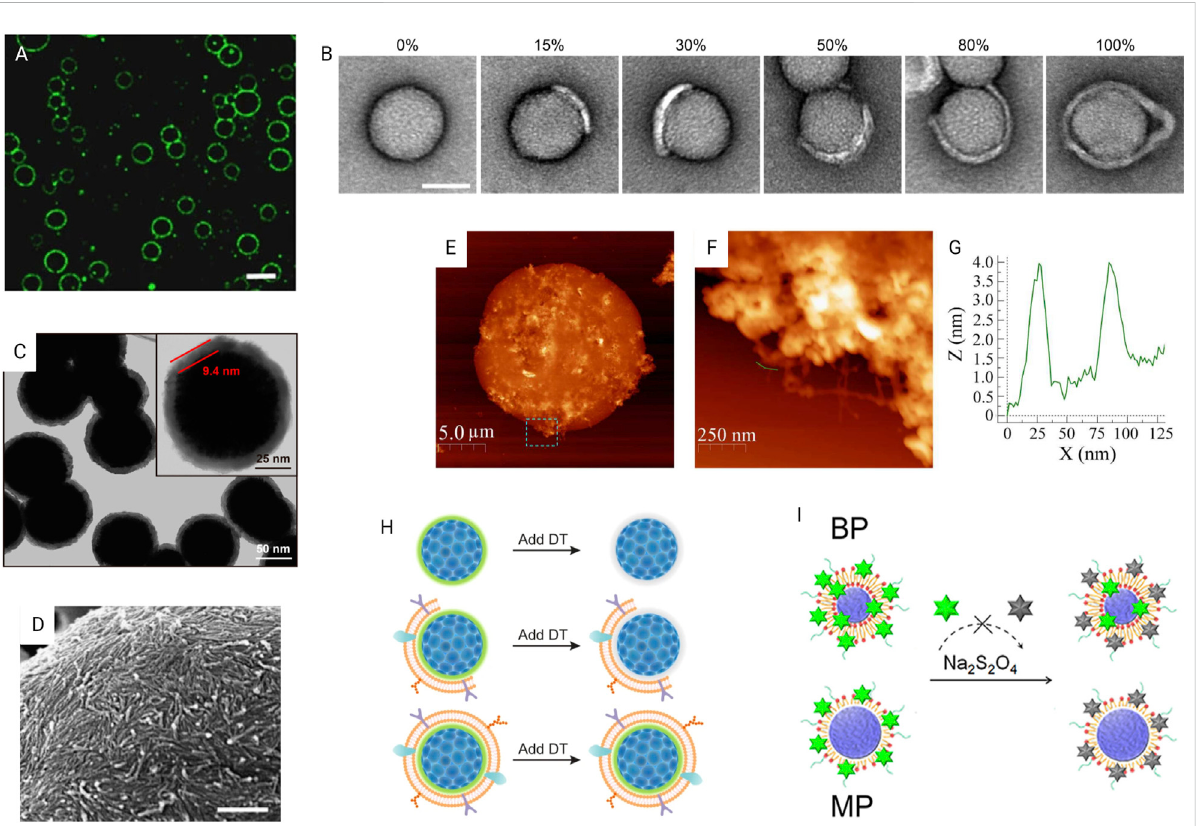
FIGURE 5 Characterization ofsurfacemodi fi cation. (A) Confocal fl uorescence microscopy imageoflysozyme fi bril-coatedw/w emulsion droplets.Scale bar, 20 mm by Song et al. (2016) licensed under CC BY 4.0. (B) TEM images of CM-coated NPs with different coating percentages. Scale bar, 50 nm (Liu et al., 2021) licensed under CC BY 4.0. (C) TEM image of RBCM-coated NPs with enlarged image showing thickness of the coating; Reprinted withpermissionfromRaoetal.(2017).Copyright2017AmericanChemicalSociety. (D) SEMimageshowingaccumulationofnano fi brilsinaself- assemble coating. Scale bar, 500 nm by (Song et al., 2016) licensed under CC BY 4.0. (E) AFM image showing the surface texture of a hydrogel- outgrown proteinosome with the (F) magni fi ed image of the dashed box area marked in (E) showing outgrown hydrogel fi laments and (G) corresponding height pro fi le measured by AFM to determine fi lament thickness of 2 – 4 nm by (Mu et al., 2021) licensed under CC BY 4.0. (H) Fluorescence quenching assay of quantifying fully coated particle percentage by Liu et al. (2021) licensed under CC BY 4.0. (I) Fluorescence quenching method using NBD-labeled lipid-PLGA NPs to verify the lipid shell structure. Reprinted with permission from Zhang et al. (2015). Copyright 2015 American Chemical